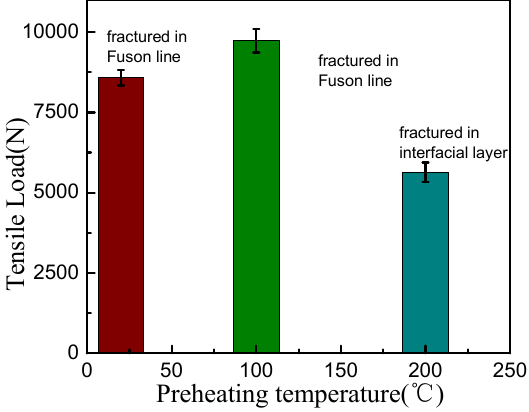
Figure 10. Tensile force and fracture position at different preheating temperatures. Appl. Sci. 2018 , 8 , x FOR PEER REVIEW